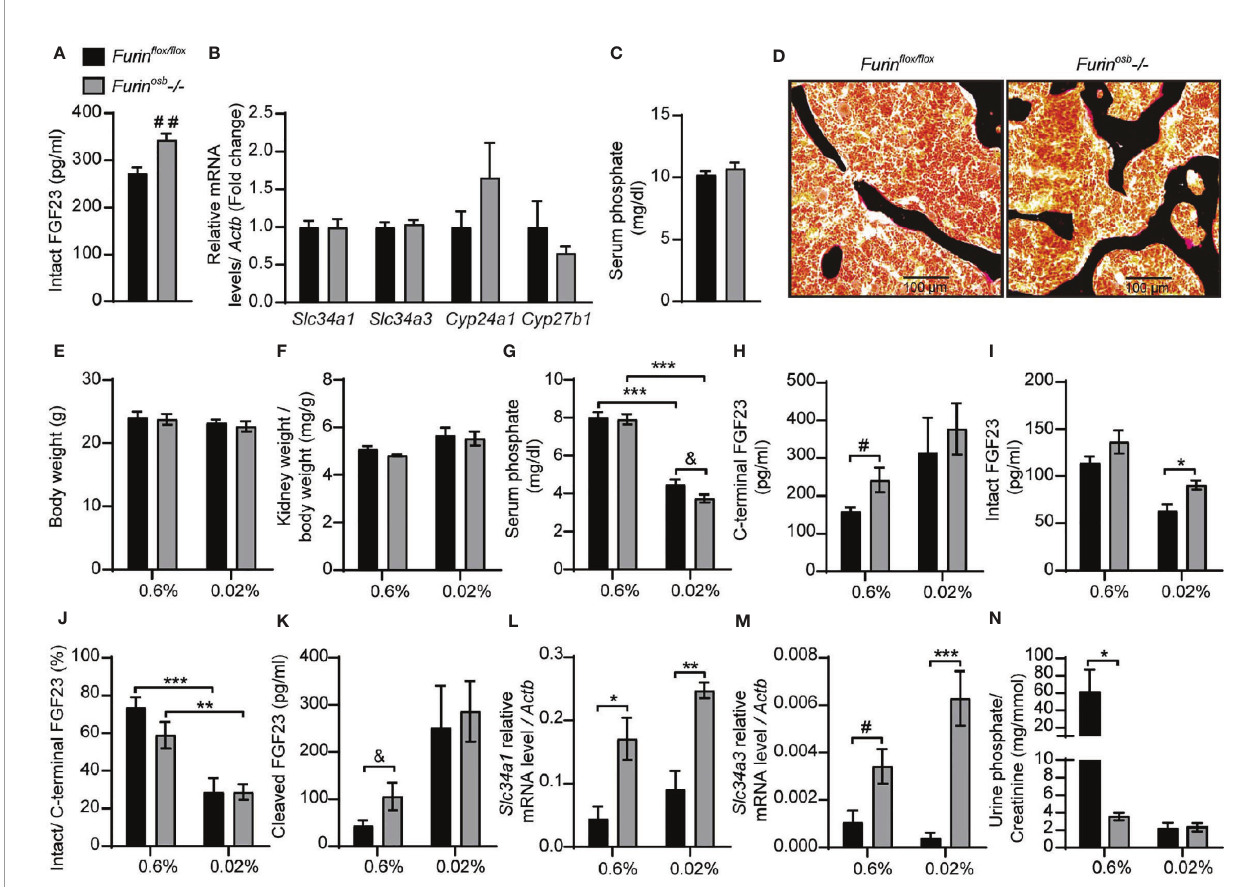
FIGURE 1 | Increased FGF23 level and reduced phosphate excretion in Furin osb-/- mice. FGF23 and phosphate levels in in 4-month-old Furin fl ox/ fl ox (n=6) and Furin osb -/- (n=6) mice fed on standard chow diet (see Material and Methods ) (A – D) . Intact FGF23 levels in plasma (A) . FGF23 target genes expression in kidney (B) . Serum phosphate level (C) . Von Kossa/van Gieson staining on vertebrae sections (D) . FGF23 and phosphate parameters in 6-months-old Furin fl ox/ fl ox (n=6) and Furin osb -/- (n=6-7) mice fed a normal phosphate diet (0.6%; see Material and Methods ) or a low phosphate diet (0.02%; see Material and Methods ) for one week (E – N) . Body weight (E) . Kidney weight normalize to body weight (F) . Serum phosphate levels (G) . Plasma level of C-terminal FGF23 (H) , intact FGF23 (I) , percentage (%) of intact over C-terminal FGF23 (J) and cleaved FGF23 levels (K) calculated as (C-terminal FGF23) - (intact FGF23). Expression level in kidney of the sodium phosphate cotransporter Slc34a1 (L) and Slc34a3 (M) . (N) Urine phosphate measurements normalized to creatinine. Results represent the mean ± SEM. * P < 0.05, ** P < 0.01, and *** P < 0.001, by 2-way ANOVA with Bonferroni ’ s multiple comparisons test or by Student ’ s t-test (A – C, G, H, K, M) #: P <0.05; ##: P <0.01; &: 0.05< P